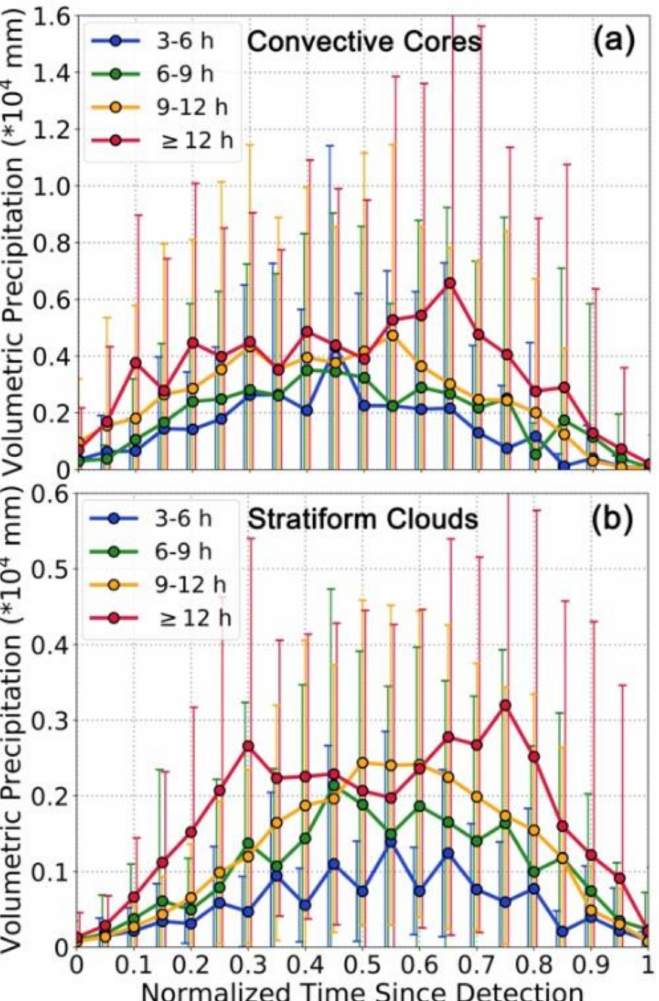
Figure 10. Line charts showing the variation in volumetric precipitation of ( a ) convective cores, and ( b ) stratiform clouds during the life cycle. The error bars represent standard deviations of the composite curves of MCSs with di ff erent